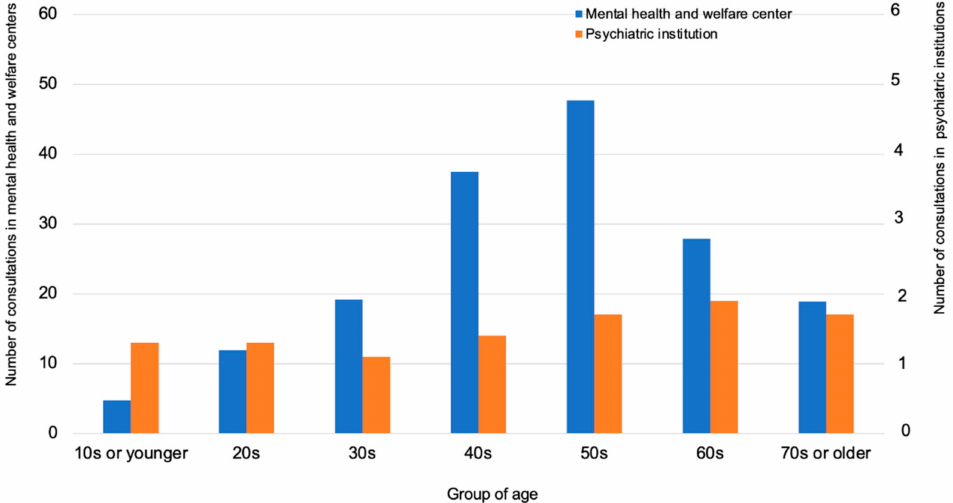
Figure 4. Number of consultations by age